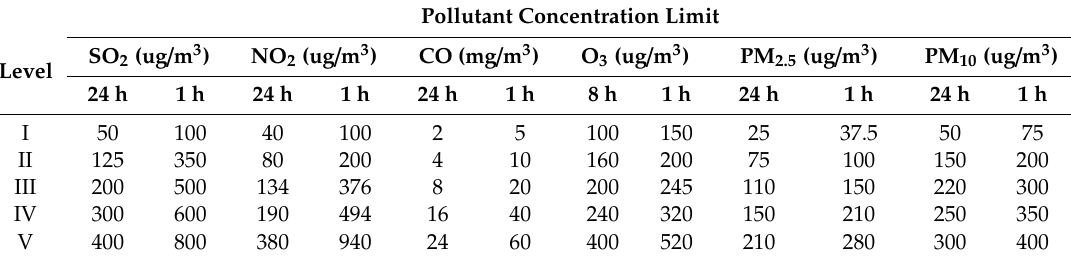
Table 2. A new calculation grid for